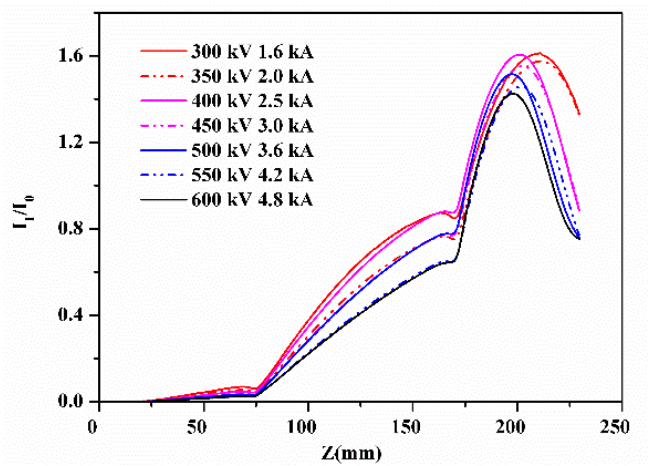
Figure 10. The first harmonic current distribution versus electron beam voltage and current.